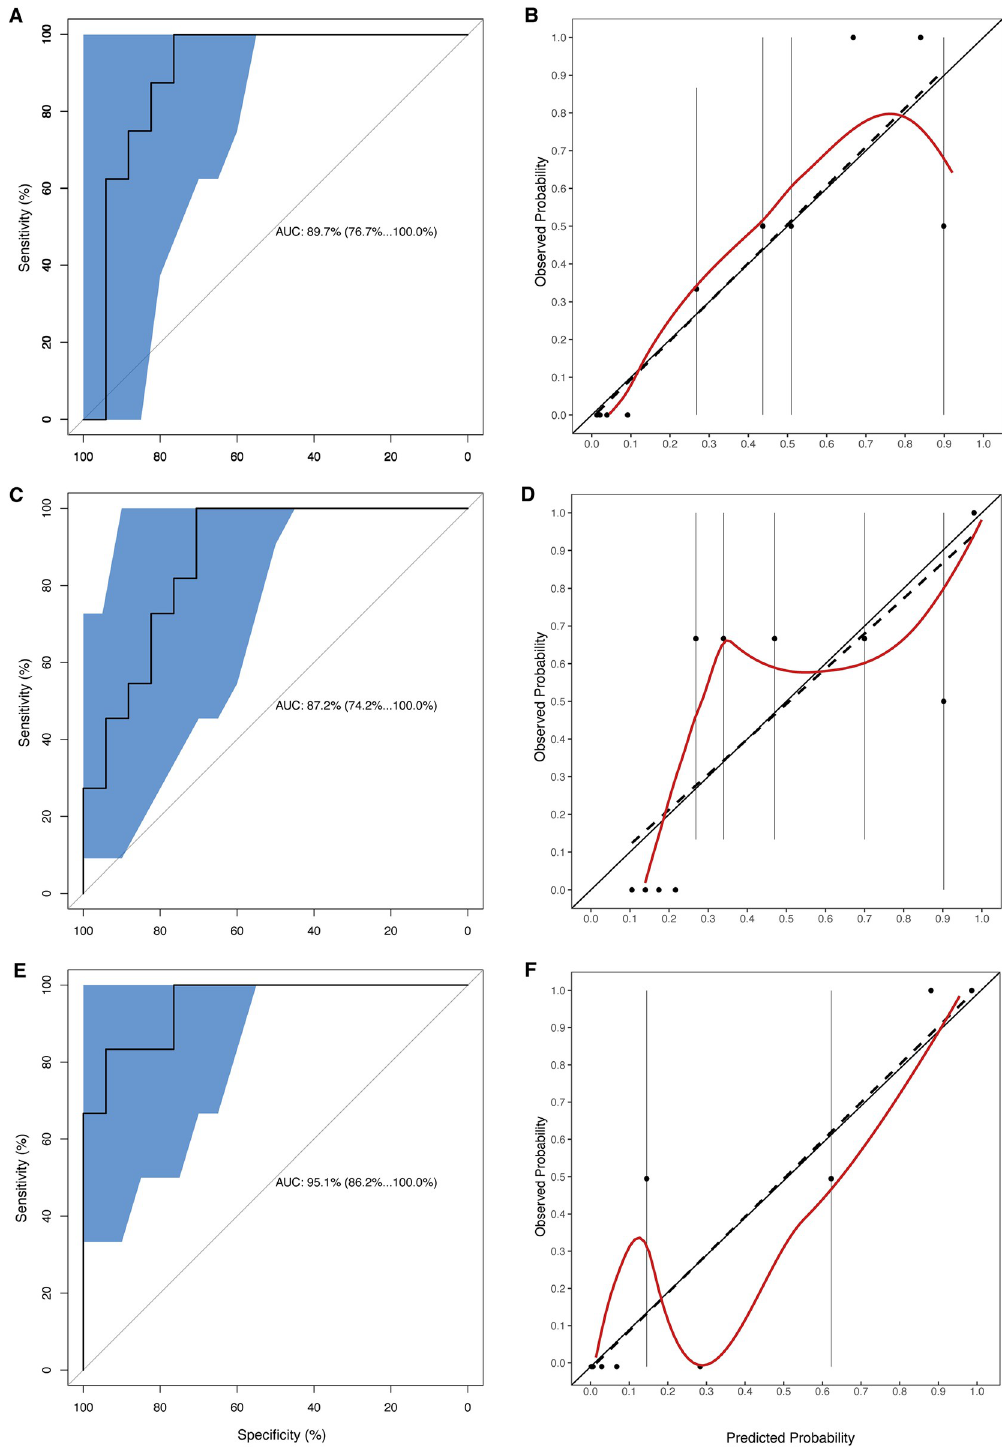
Fig 3. Discrimination and calibration curves. Area under the receiver operating characteristic curves (AUC) (A, C, E) and calibration curves (B, D, F) of the Ebola Virus Disease Prognosis in Children (EPiC) model are shown with aspartate aminotransferase (AST) (A, B), creatine kinase (CK) (C, D), or both (E, F) as additional predictors for the Democratic Republic of the Congo validation dataset. The interpretation of the plots is the same as in Fig 2.